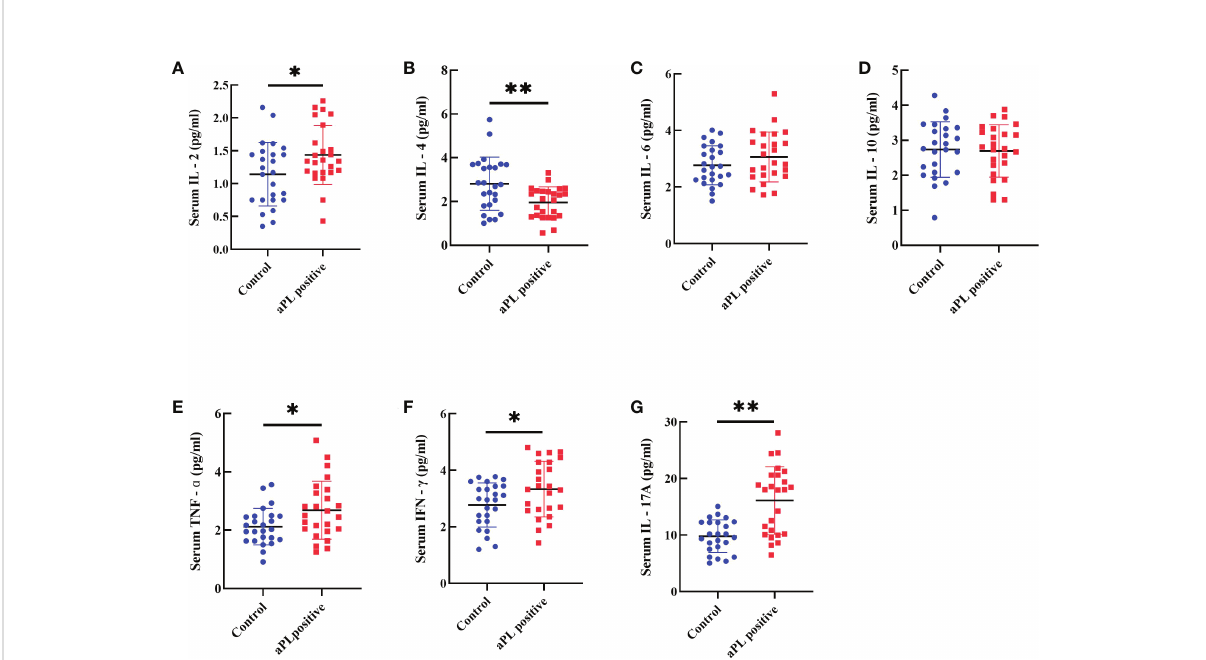
stimulation, total Gn dose, and the numbers of retrieved oocytes and embryos. The number of perfect/available embryos, perfect/ available embryo rate, M II oocyte rate, blastocyst formation rate, and normal fertilization rate were all higher in the treatment group than in the controls. In agonist protocol, the number of perfect/available embryos, perfect/available embryo rate, blastocyst formation rate, and normal fertilization rate were signi fi cantly higher in the treatment group than in the non- treated group. In antagonist protocol, the number of perfect/ available embryos and perfect/available embryo rate were signi fi cantly increased. In PPOS protocol, the perfect/available embryo rate was signi fi cantly increased compared to